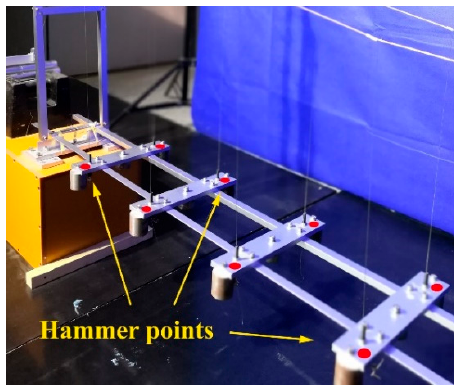
Figure 14. Laboratory mock-up of the suspension bridge.